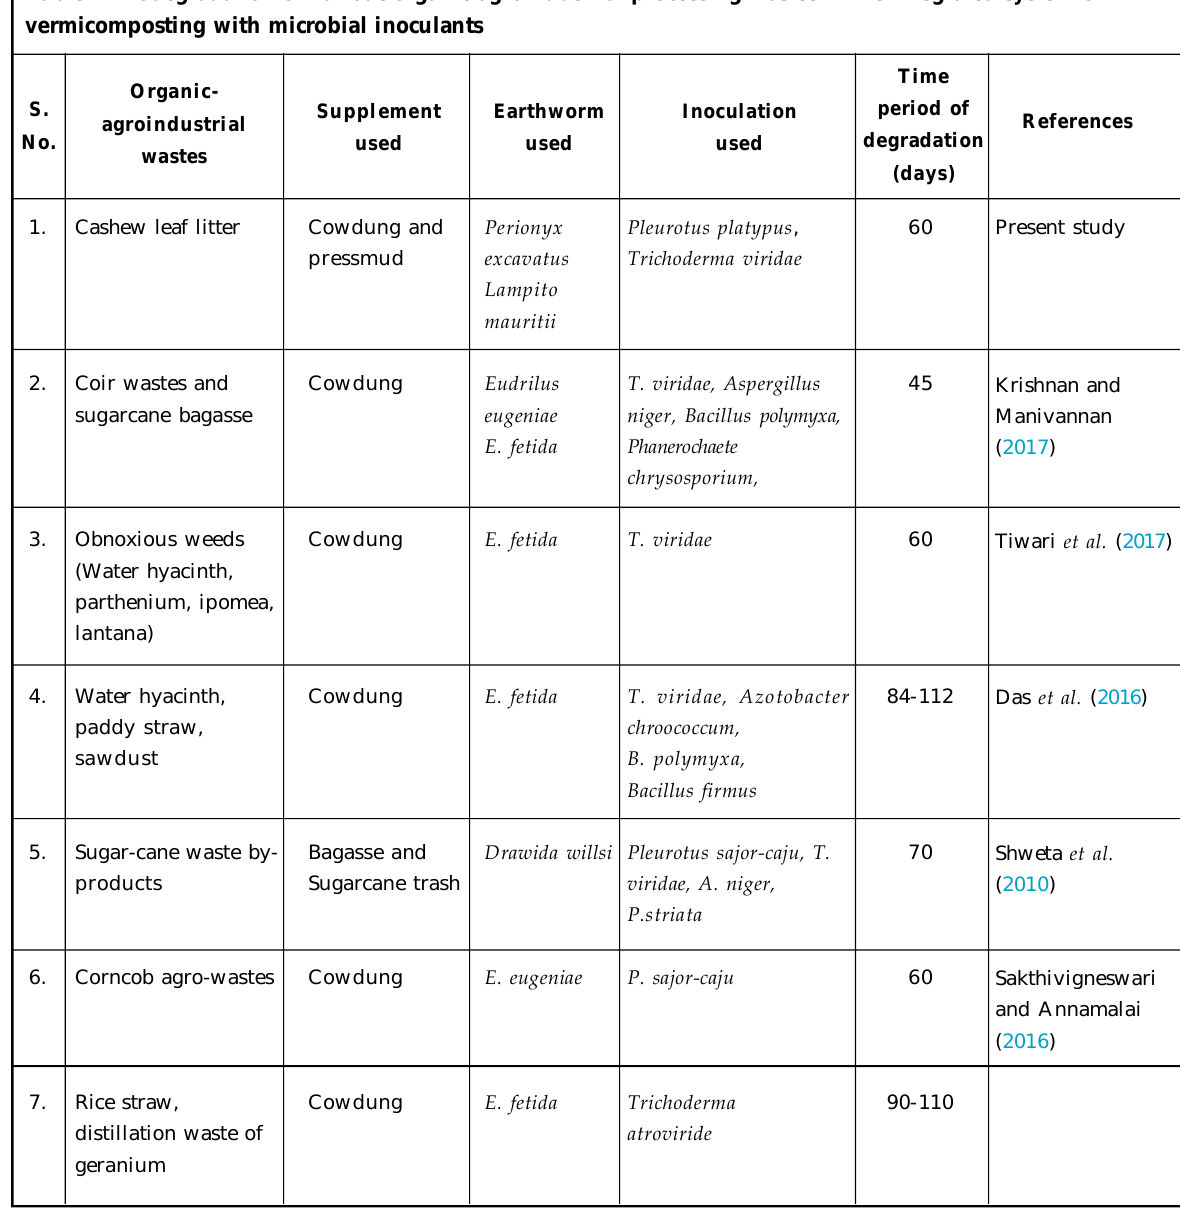
Table 1: Biodegradation of various organic-agroindustrial processing wastes in the integrated system of vermicomposting with microbial inoculants